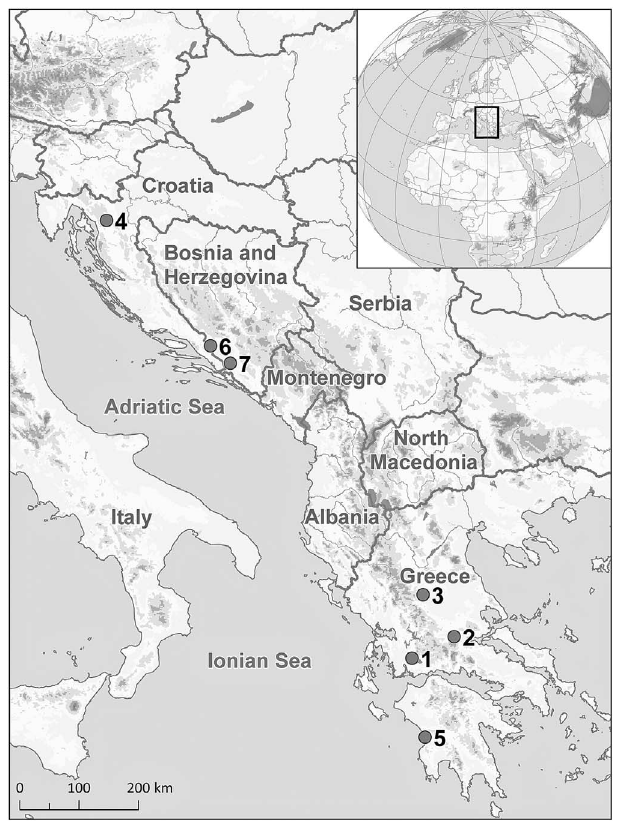
Figure 1. Map showing the sampling localities (numbers) for each host species of the Balkan Peninsula near the eastern coast of the Adriatic and Ionian Sea. (1) Trichonis Lake, Panetolio; (2) Spercheios River, Ypati; (3) Pineios River, Rongia – Valamandrio; (4) Su š ik River, Dre ž nica; (5) Neda River, Giannitsochori; (6) Nezdravica River, Tihaljina; (7) Re č ina River, Hutovo Blato Natural